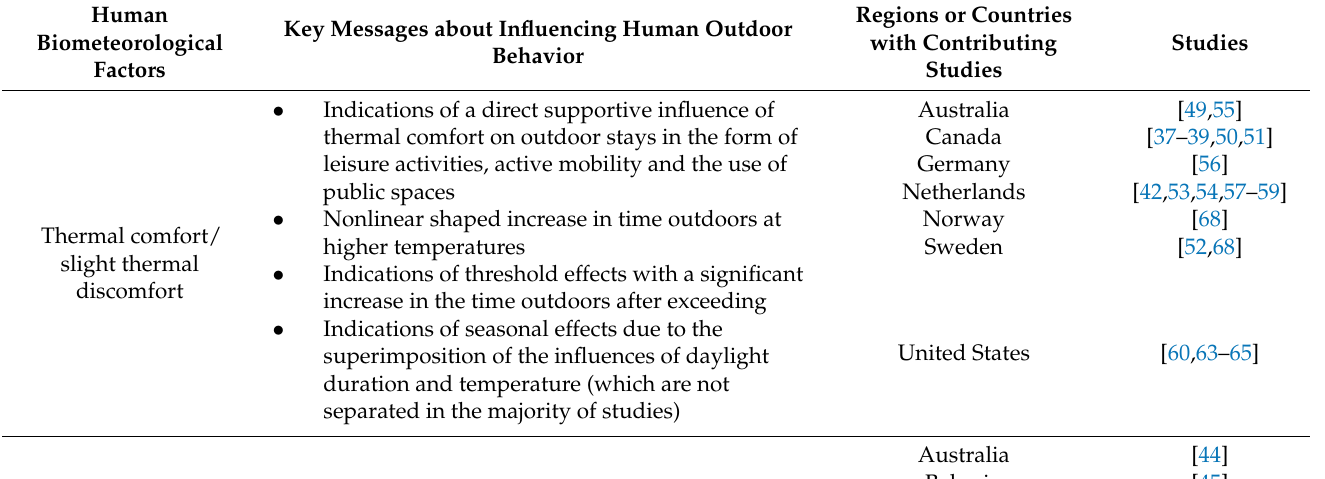
Table 5 gives a summarizing overview of the key messages. Table 5. Human biometeorological factors and the key messages about their influence human outdoor